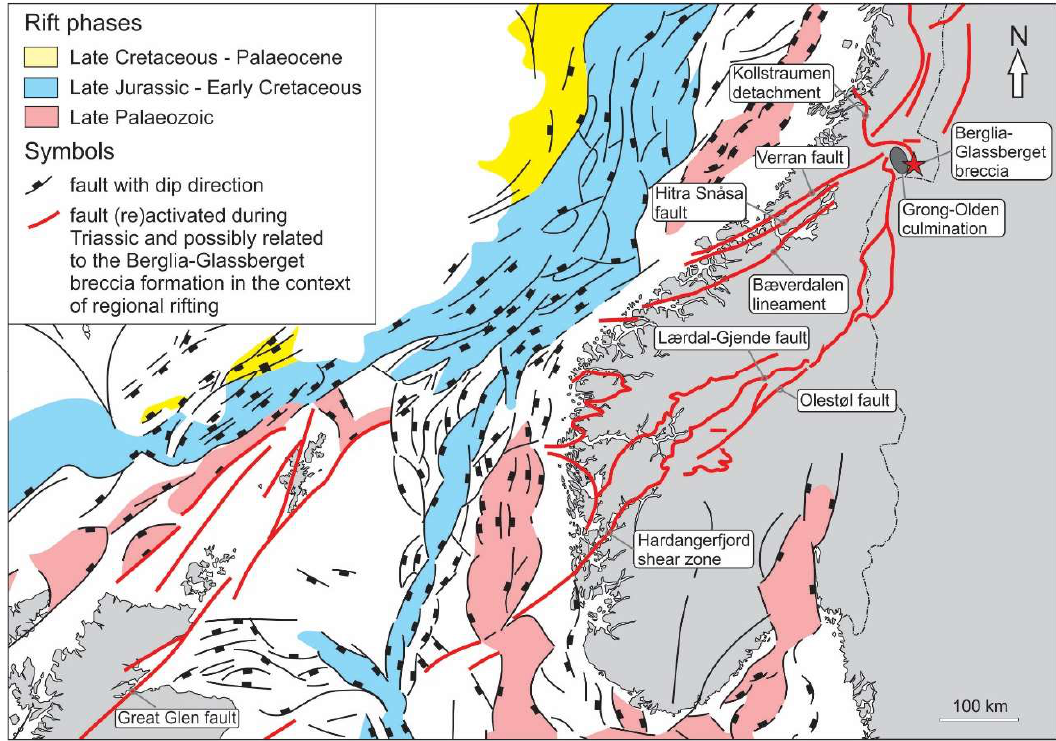
Figure 12. Geotectonic setting and relationship to the Møre Trøndelag Fault Complex (MTFC) comprising the Hitra-Snåsa and Verran faults. Main post-Caledonian structural elements of southern Norway, the Norwegian continental shelf and adjacent areas related to different rift phases affecting the NE Atlantic region (from Faleide et al. [112,113] updated with onshore elements from Redfield et al. [104,105]).